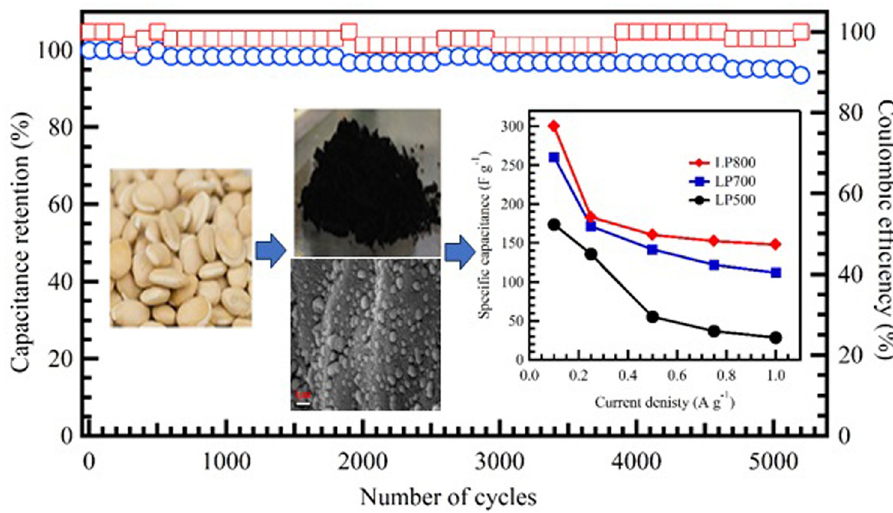
Figure 30: Capacitance retention and Coulombic e ffi ciency of PCNs obtained from Lablab purpureus. Copied with permission from ref. [ 19 ] ; Royal Society of Chemistry,